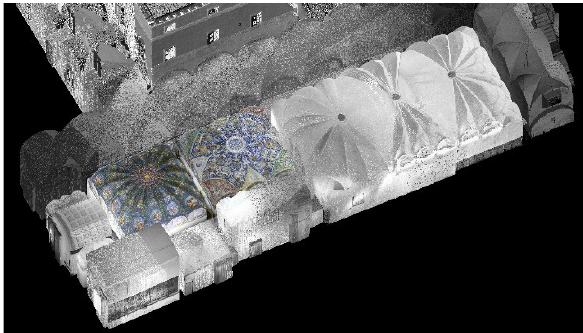
Figure 1 . The complete point cloud after registration. The two rooms investigated in this paper (R1 and R2) are represented with RGB colours. R1 is on the right of the image and R2 on the